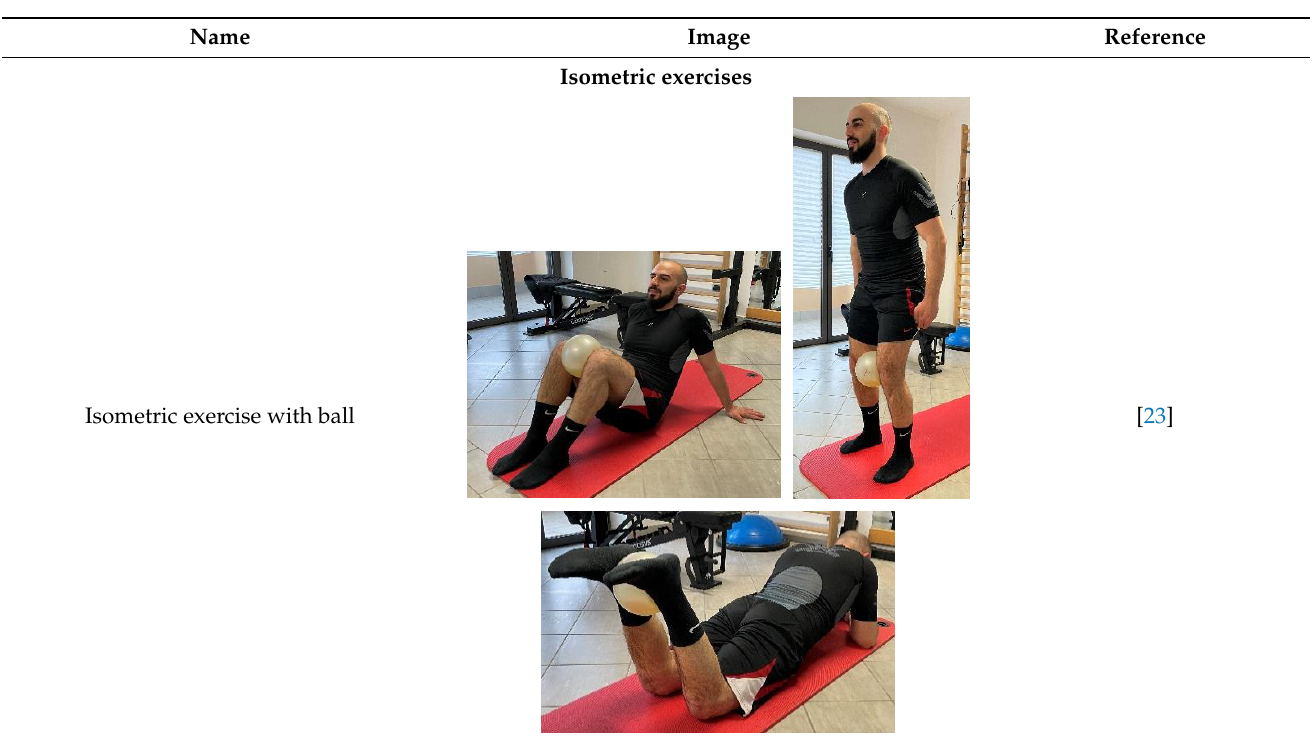
Table 4. Adductors rehabilitation exercises.